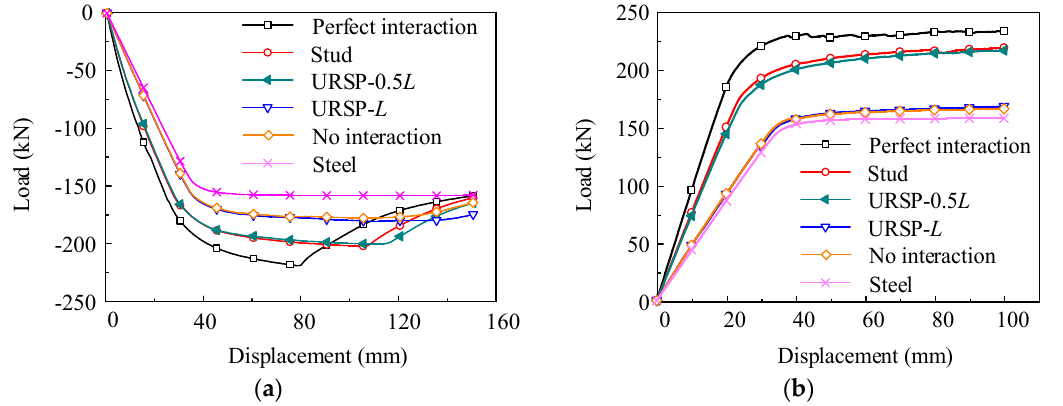
Figure 9. Load-displacement results. ( a ) Hogging moment; ( b ) sagging moment. Note: For clarity,